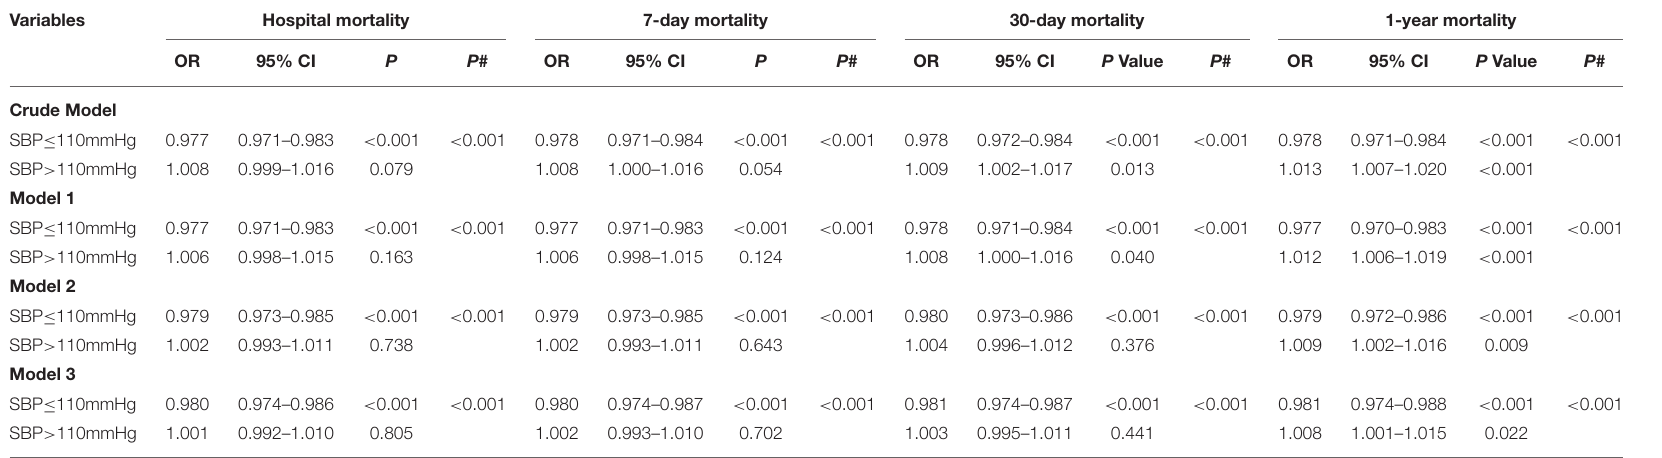
TABLE 4 | Multiple logistic regression analysis for relationship between SBP and mortality